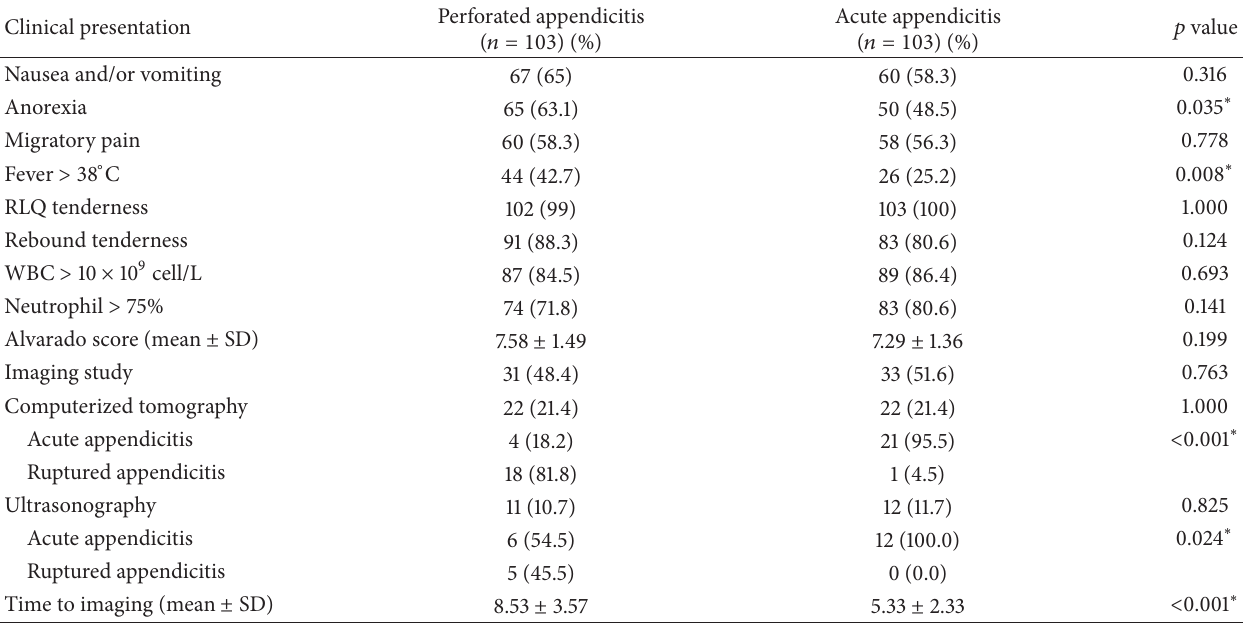
Table 2: Comparison of clinical presentation in the two groups.